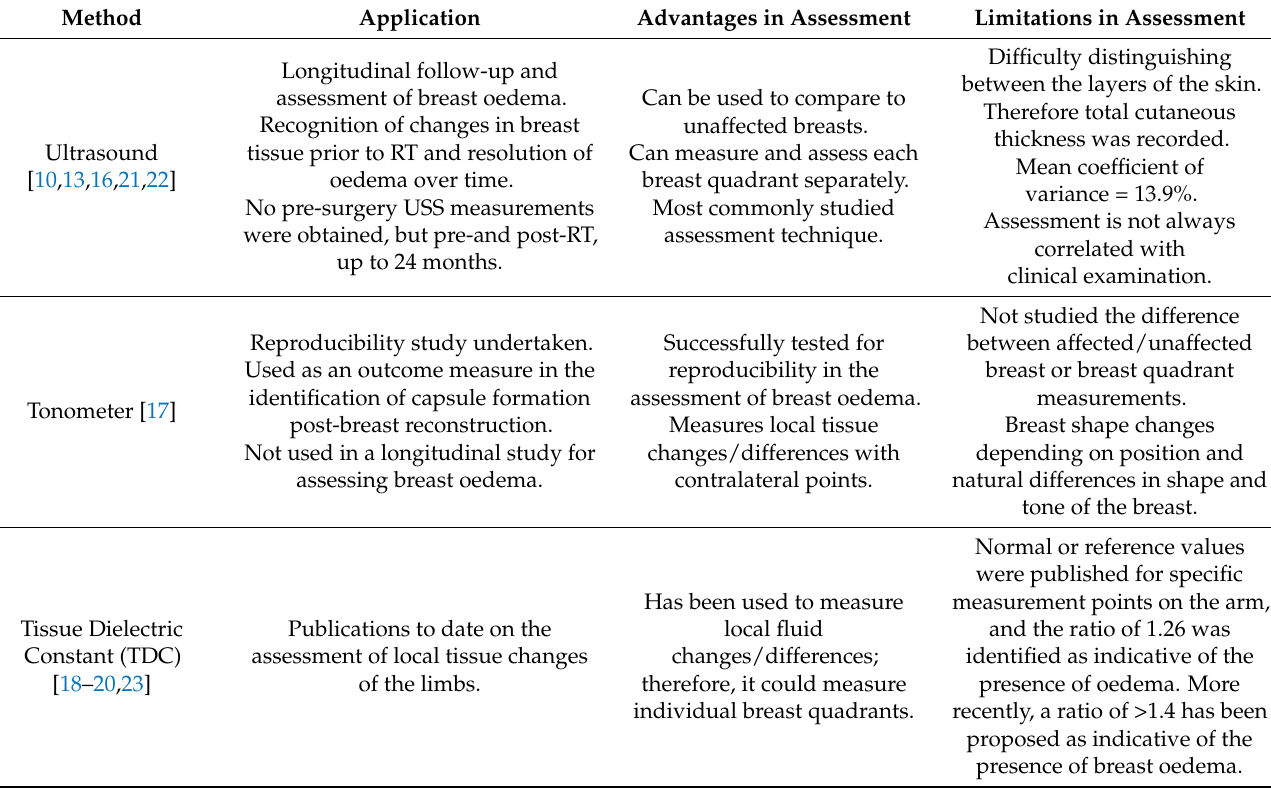
Table 1. Advantages, disadvantages and limitations of the measurement methods